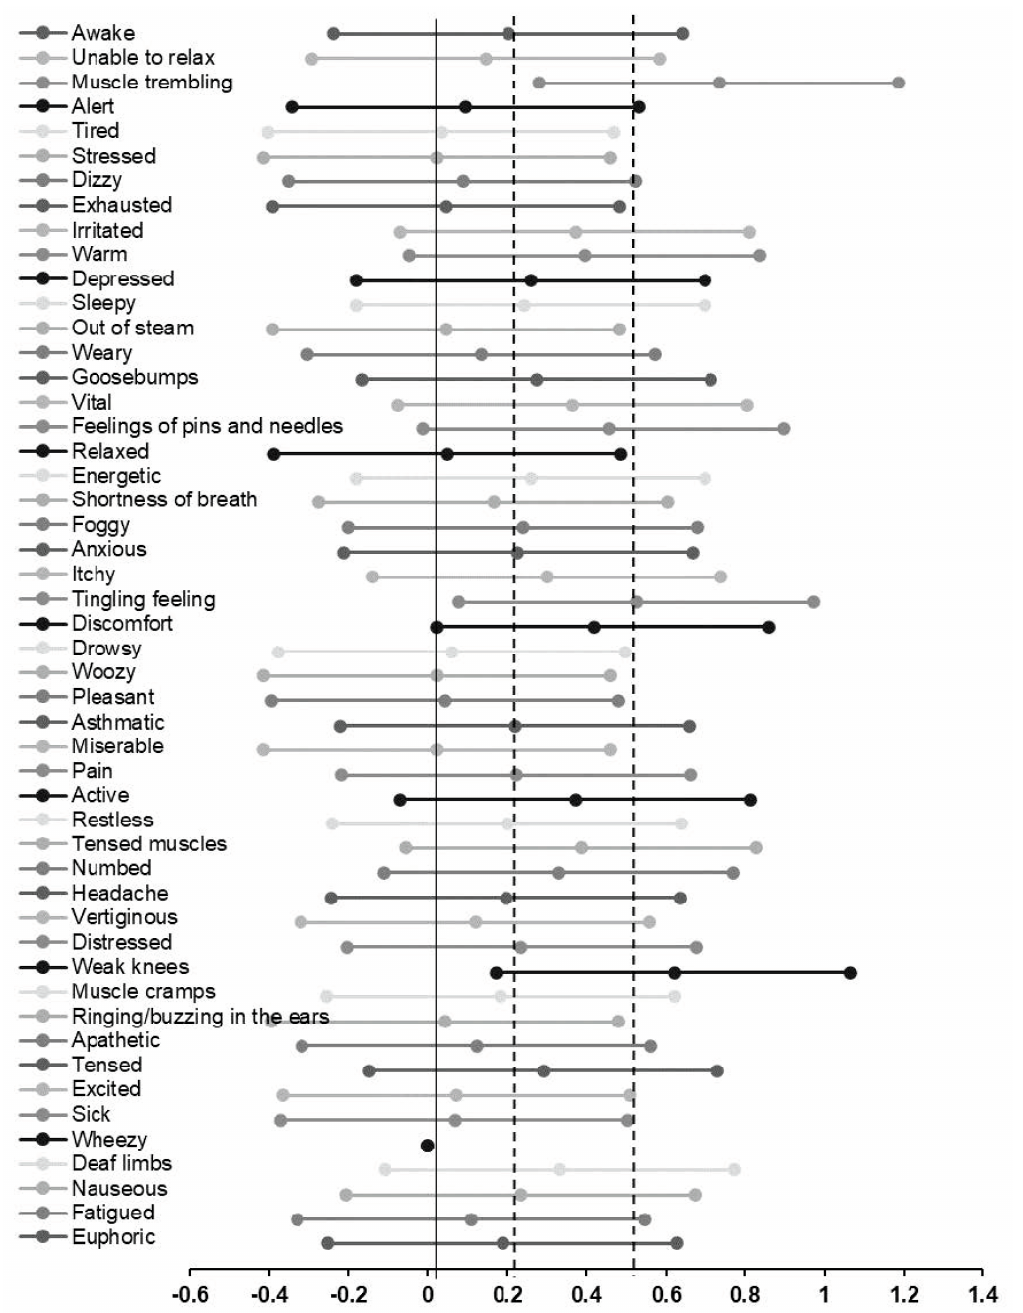
Figure 4. Forest plot of how 88 subjects felt immediately after WBV (intensity of experiences) in effect sizes (Cohen’s d) and 95% CI’s (adopted from Oerlemans et al. [75]).